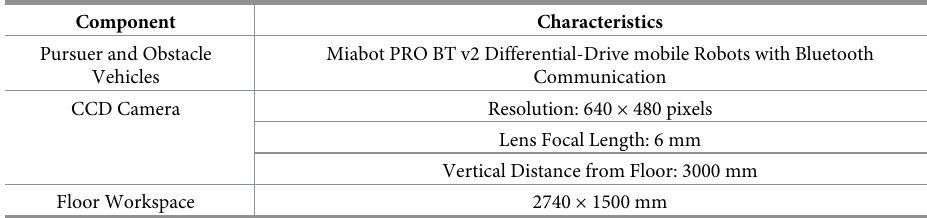
Table 11. Experimental hardware specifications.